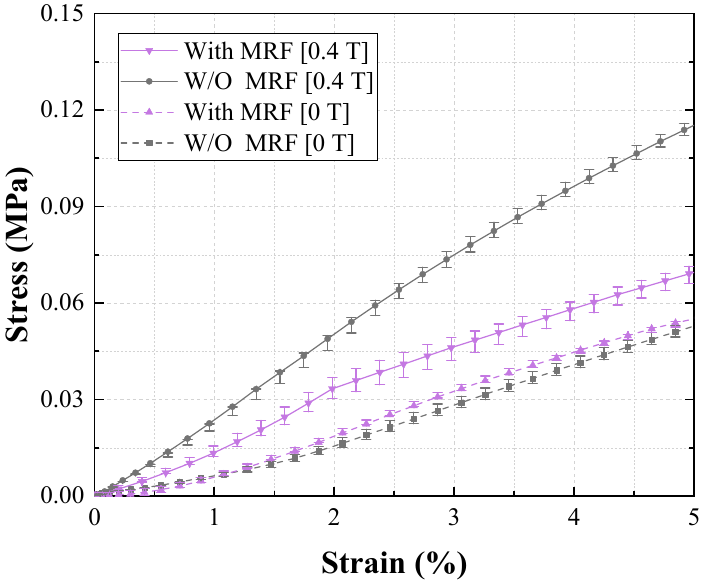
Figure 12. Effect of MRF contained in the channels of the lower MRE layer on Young’s modulus.